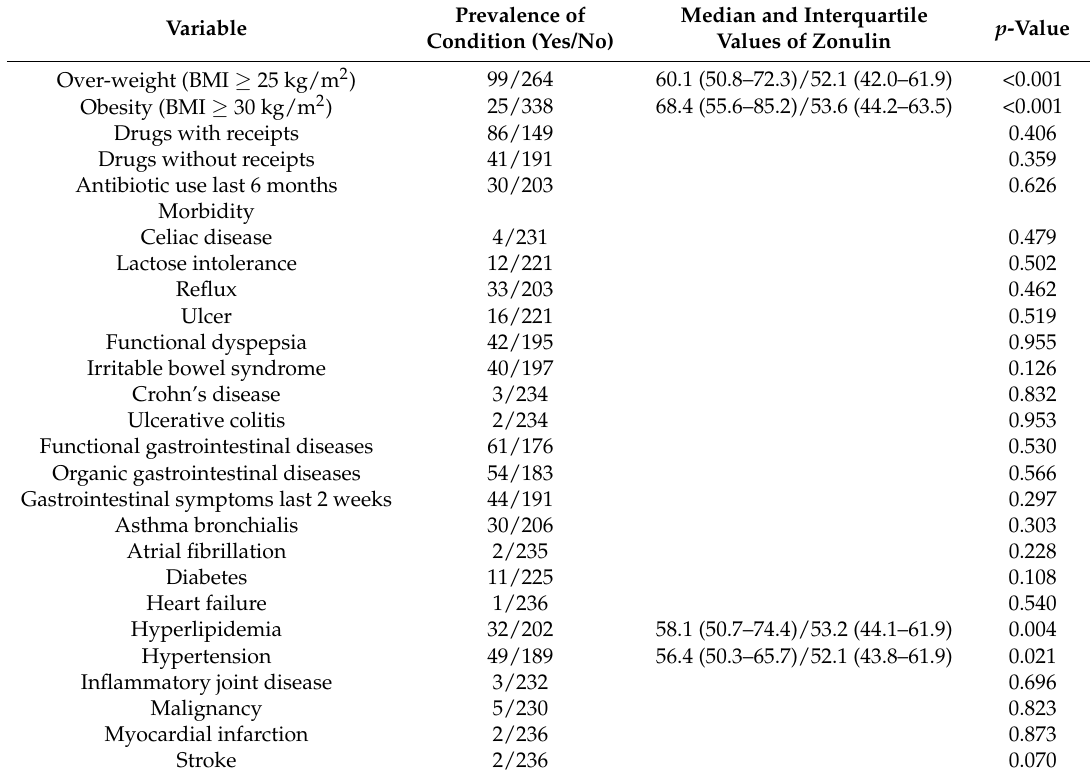
Table 4. Zonulin levels in relation to drug intake and various disease conditions.